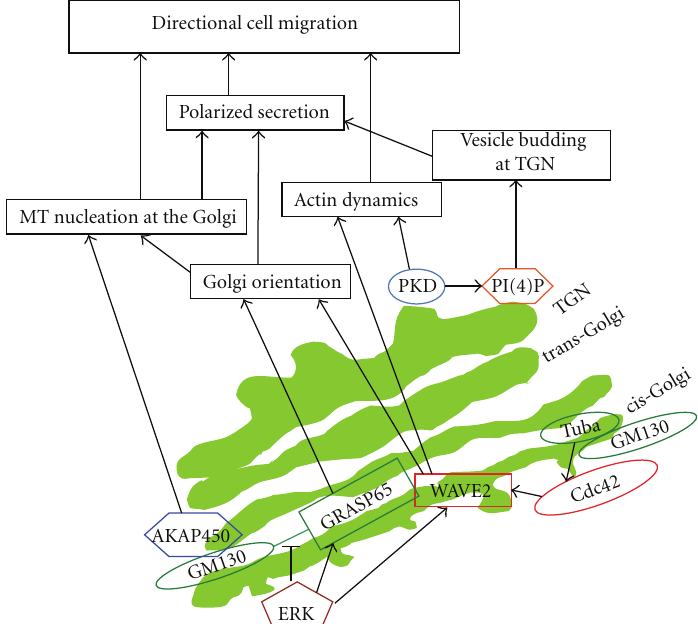
Figure 2: Schematic illustration of signaling events at the Golgi that regulate directional cell migration as explained in the main text.